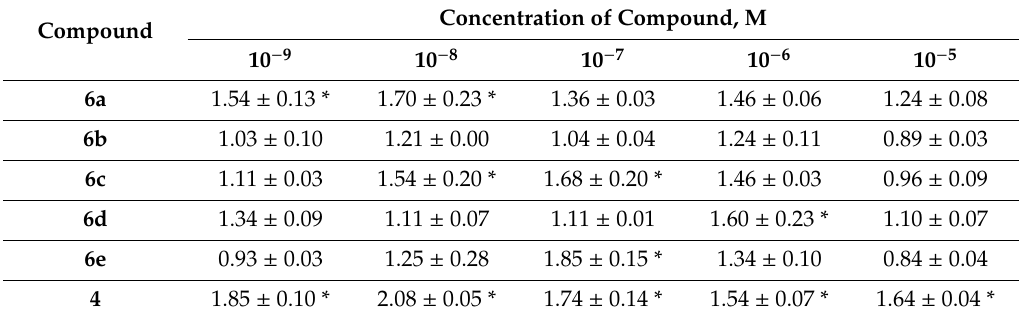
Table 7. Prooxidant activity (induction factor) of the pyrrolidine-1-carboxamides possessing a benzofuroxan moiety registered with the bacterial lux-biosensor E. coli MG1655 (pSoxS-lux).